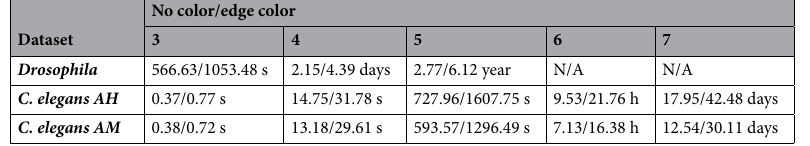
Table 4. Edge-coloring increased computation costs. Adding edge colors dramatically increases the running time for subgraph enumeration.